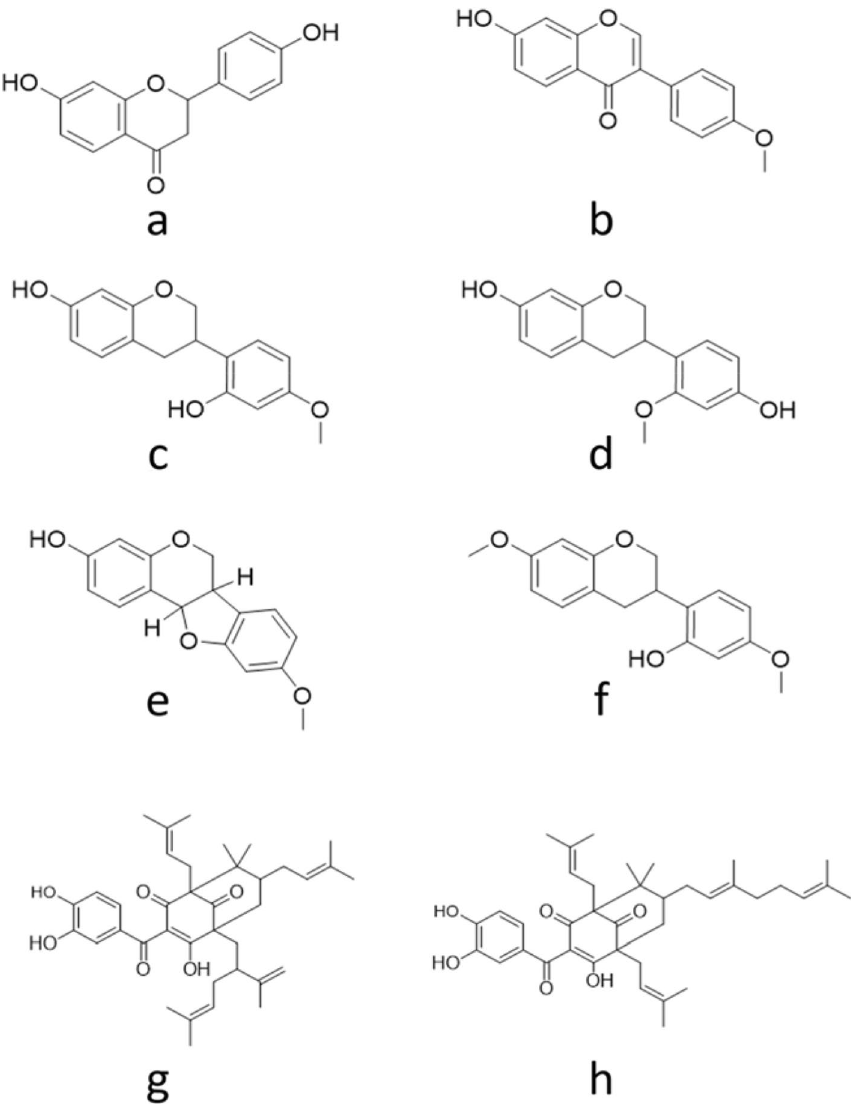
Figure 1. Chemical structures of the main constituents from Brazilian red propolis.